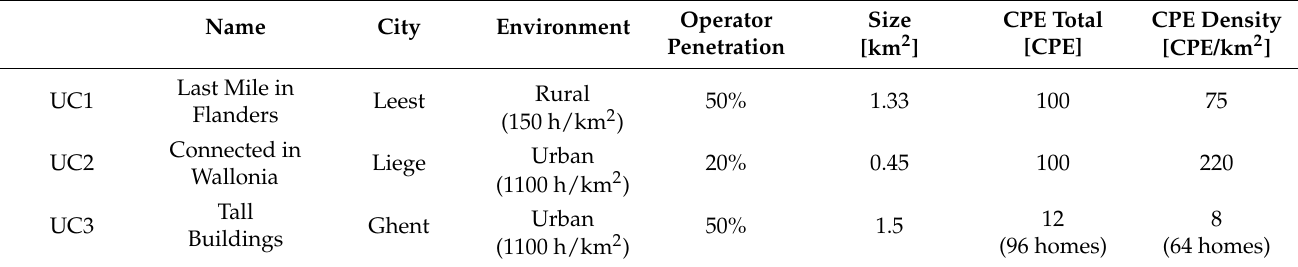
Table 2. Use case description.